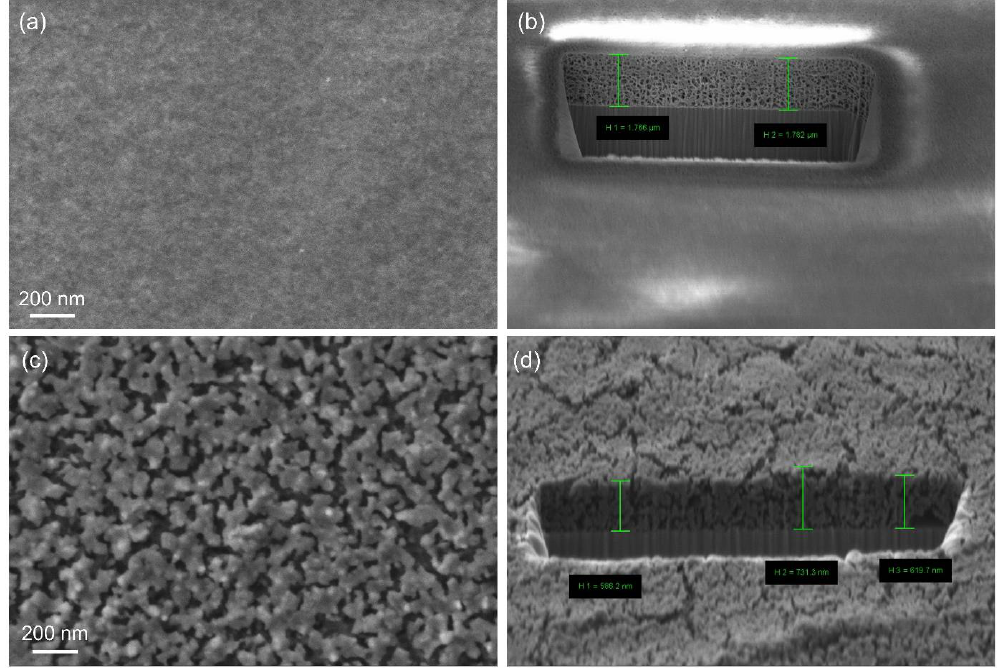
Figure 2. SEM images and FIB ablation analysis of two example layers of Al 2 O 3 (( a , b );